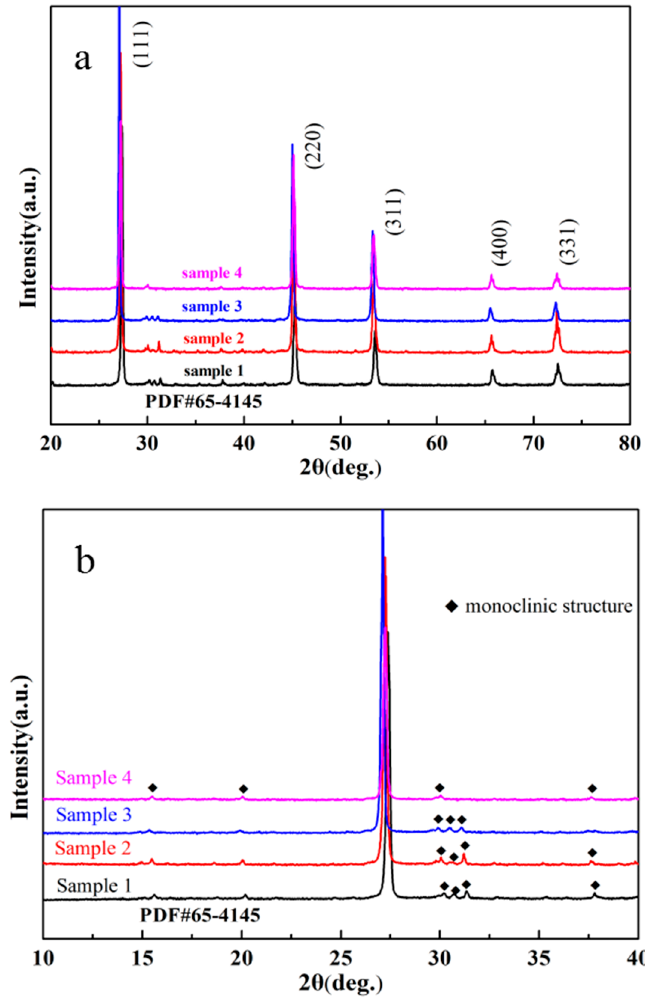
Figure 1. The X-ray diffraction (XRD) patterns of Cu 2 SnSe 3 powders with different cooling rates: ( a ) from 20° to 80°; ( b ) amplified XRD patterns from 10° to 40°. Samples 1–3 correspond to Cu 2 SnSe 3 samples with different cooling rates and sample 4 corresponds to the annealed Cu 2 SnSe 3 sample.